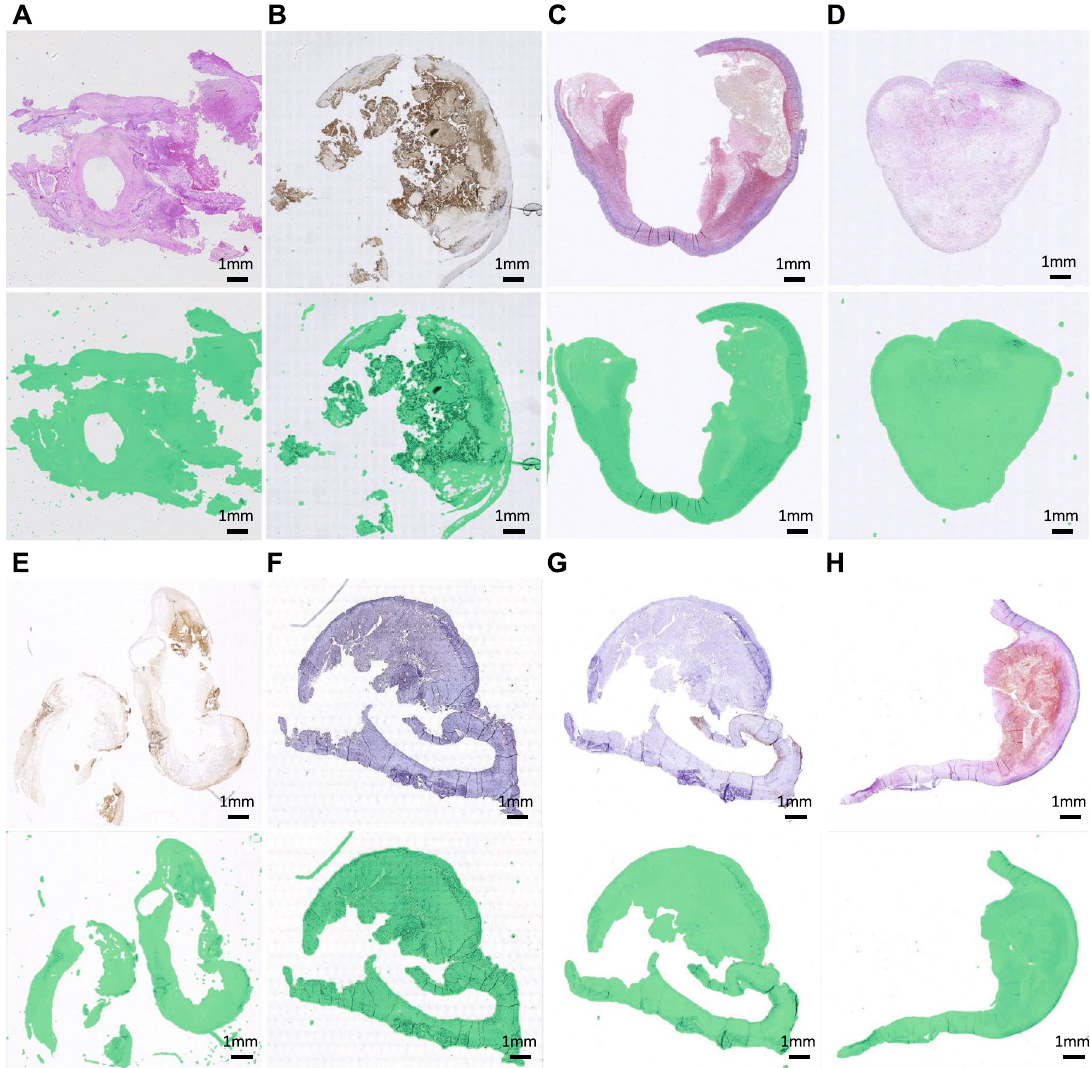
Figure 4. Generalizability across the different antibody-specific or histology stains. Images of the upper part are the original whole-slide images at layer 6 with 8 different types of staining methods respectively and images of the lower part are the examples of masking results of our EntropyMasker method where generated tissue masks are overlaid with pseudocolor (green). ( A ) H&E; ( B ) Glycophorin C; ( C ) Sirius red; ( D ) Fibrin; ( E ) CD68; ( F ) CD34; ( G ) Smooth muscle alpha-actin; ( H )